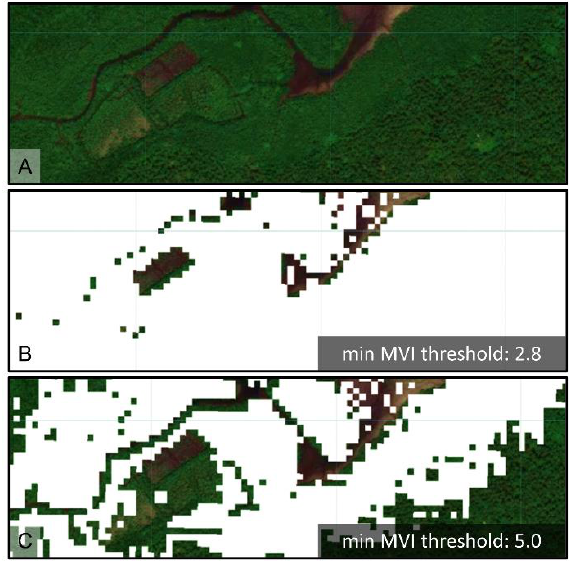
Figure 12 . Adjusted minimum threshold to reduce misclassified coconut trees on (A) true color composite: the white pixels are those identified to be mangroves using minimum MVI thresholds of (B) 2.8 as used for the MVI-based 2019 Mangrove Extent Map of the Philippines and (C) 5.0.